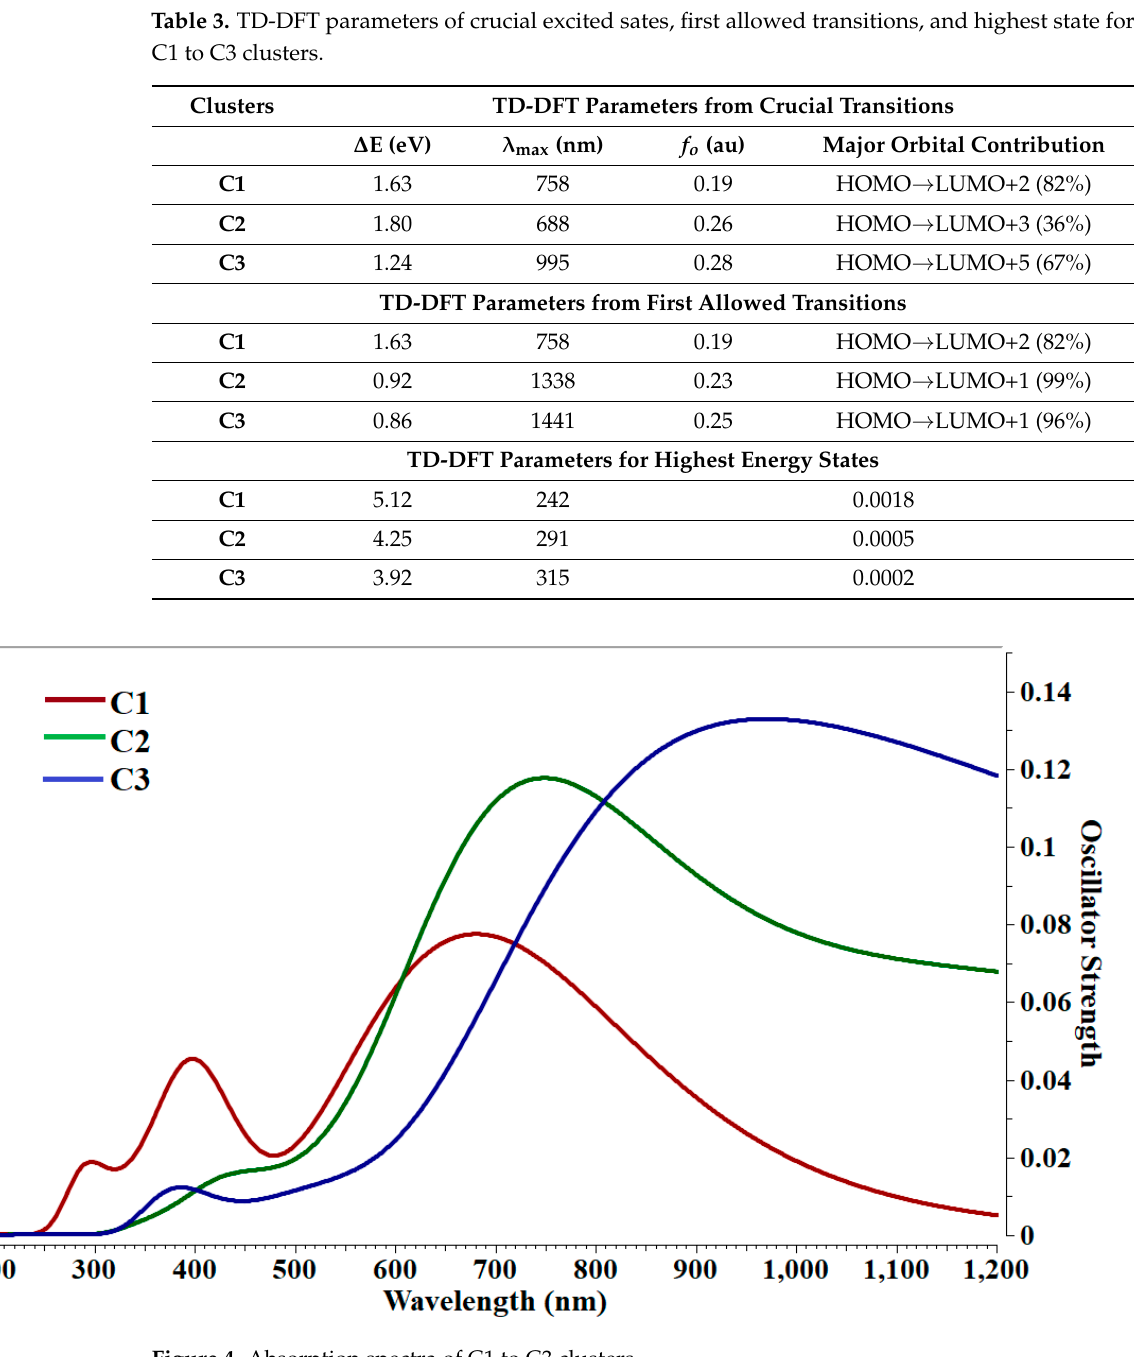
Figure 4. Absorption spectra of C1 to C3 clusters.